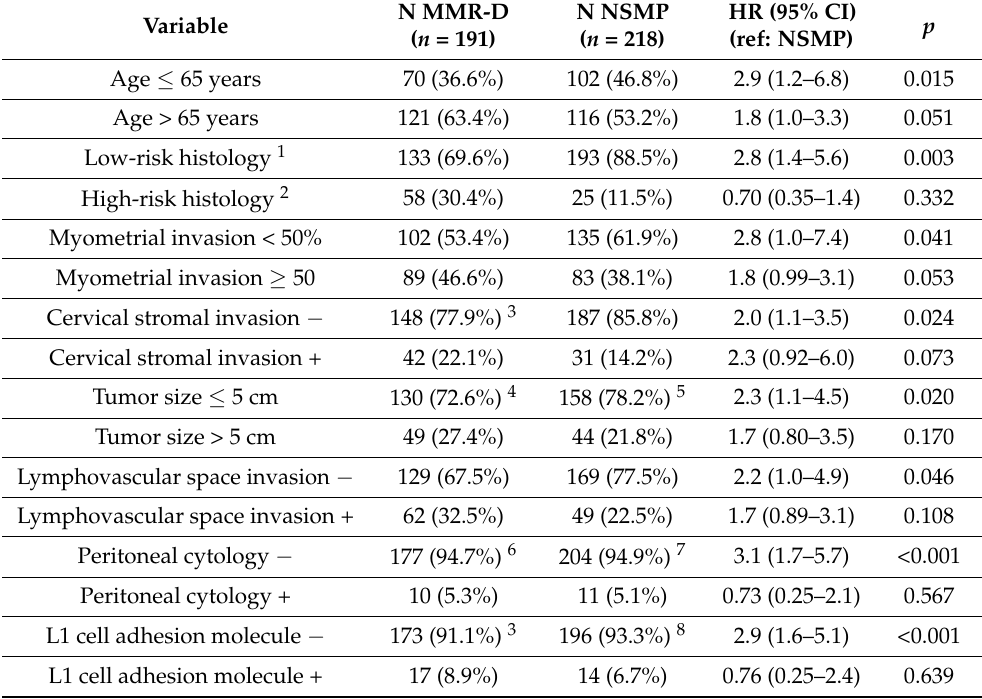
Table 4. Univariable Cox regression disease-specific survival analyses for endometrial carcinomas according to subgroups based on The Cancer Genome